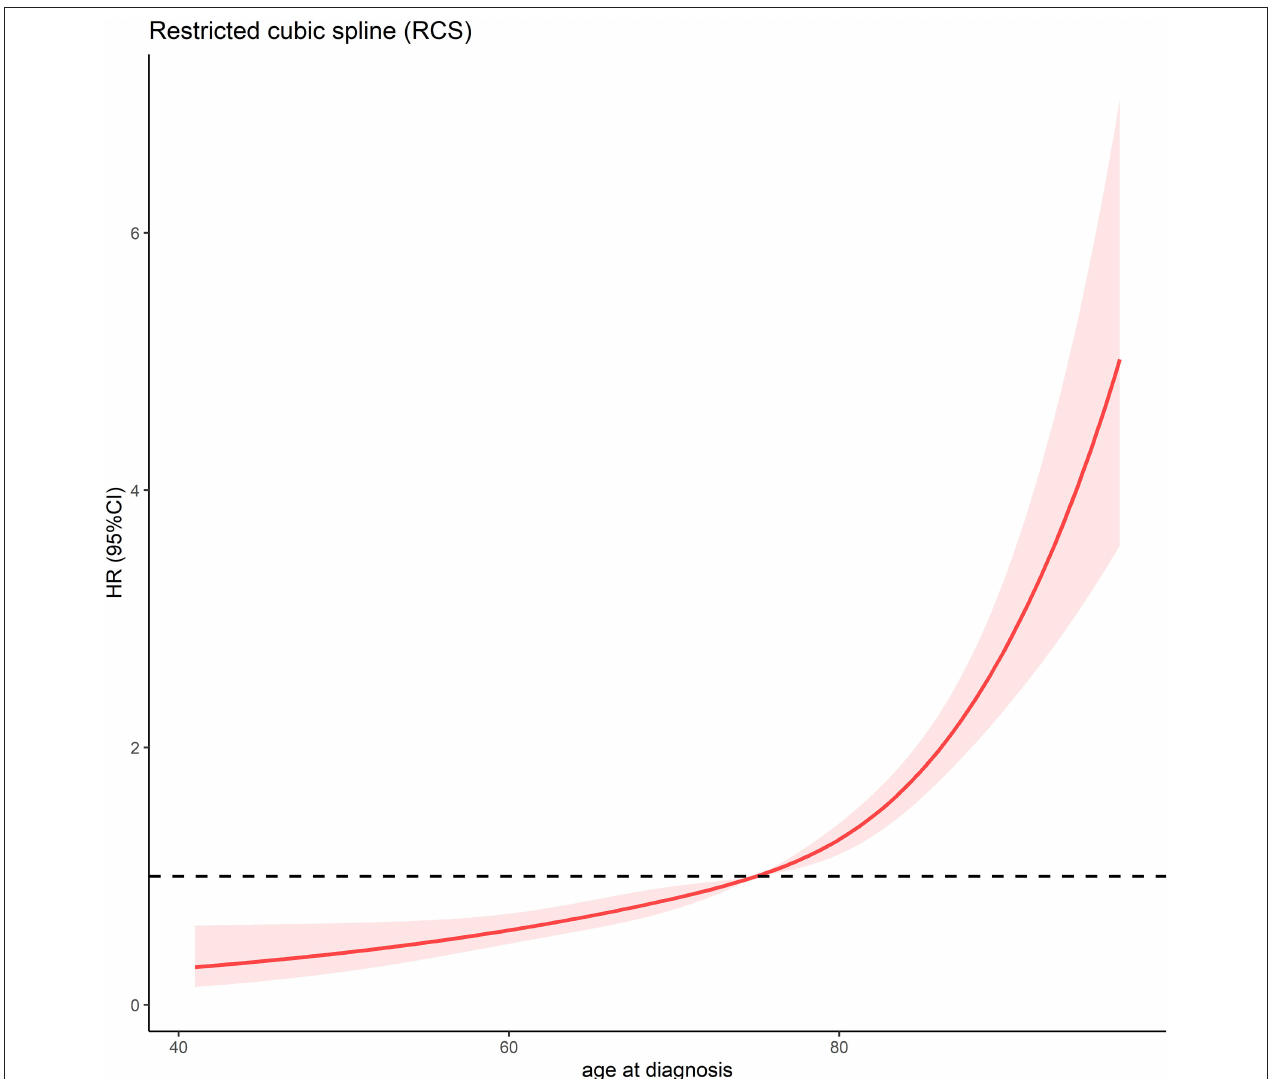
FIGURE 2 | Association between age at diagnosis and OS time using a restricted cubic spline regression model. The dotted, black line represents the 1 HR and 95% CI for the spline model (reference is 75 years